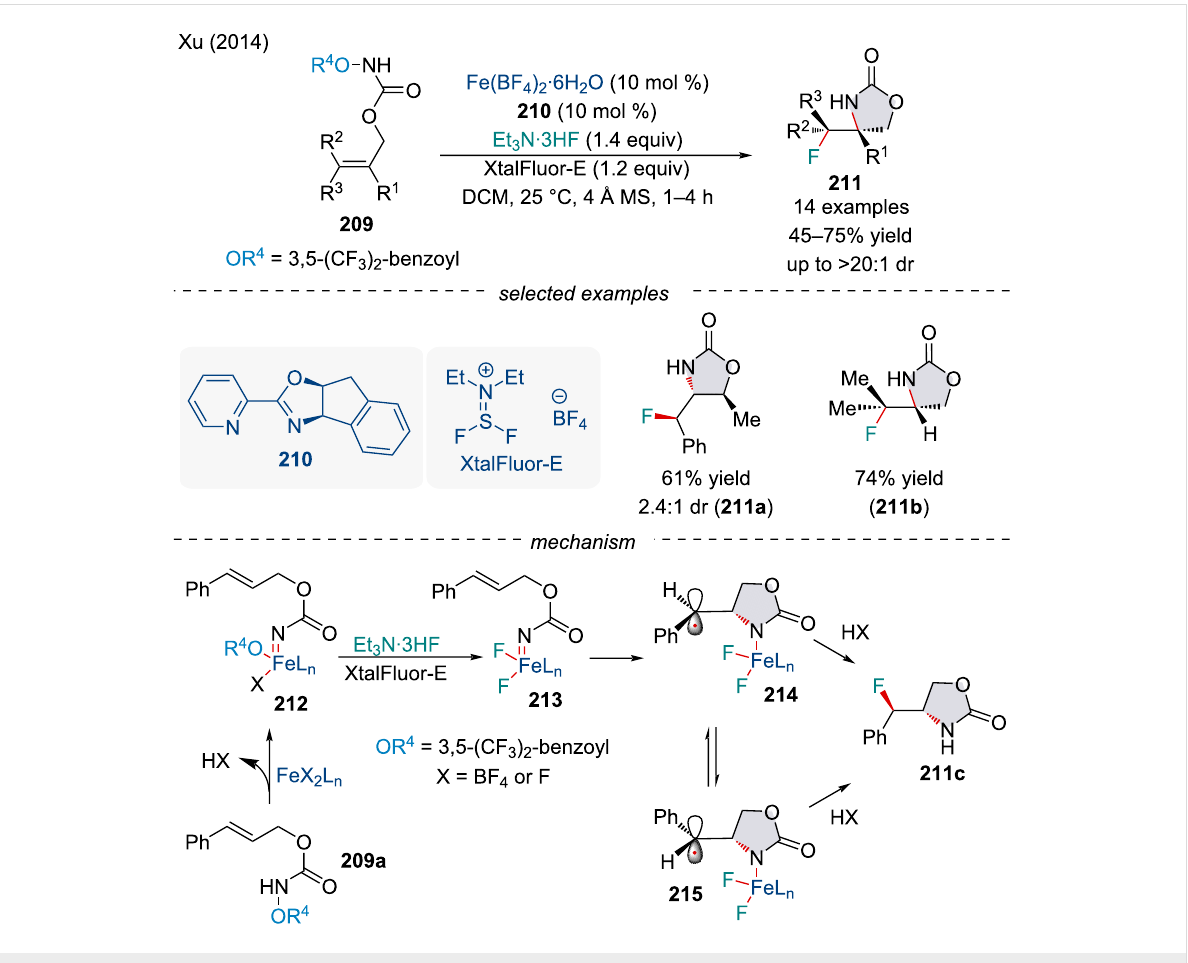
Scheme 48: Iron-catalyzed intramolecular aminofluorination of alkenes 209